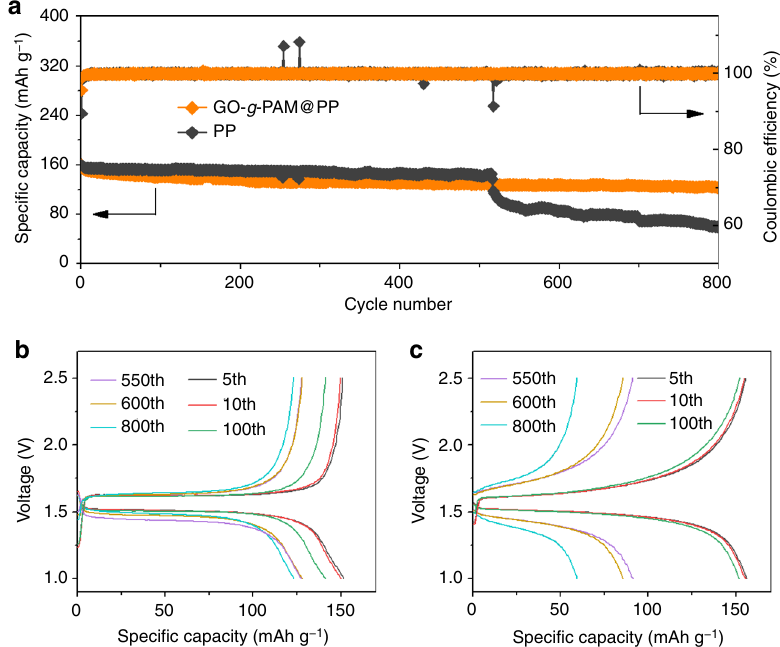
Fig. 6 Electrochemical performance of Li|Li 4 Ti 5 O 12 cells with GO- g -PAM@PP and PP separators. a Long-term cycling stability of Li|Li 4 Ti 5 O 12 cells with GO- g -PAM@PP and PP separators at a current density of 3 C (1 C = 175 mA g − 1 ). Galvanostatic charge – discharge pro fi les of Li|Li 4 Ti 5 O 12 cells with ( b ) GO- g - PAM@PP and ( c ) PP separators at 3